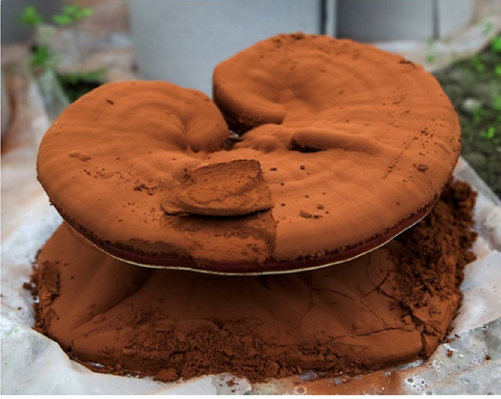
Figure 1. Digital image of Ganoderma lucid